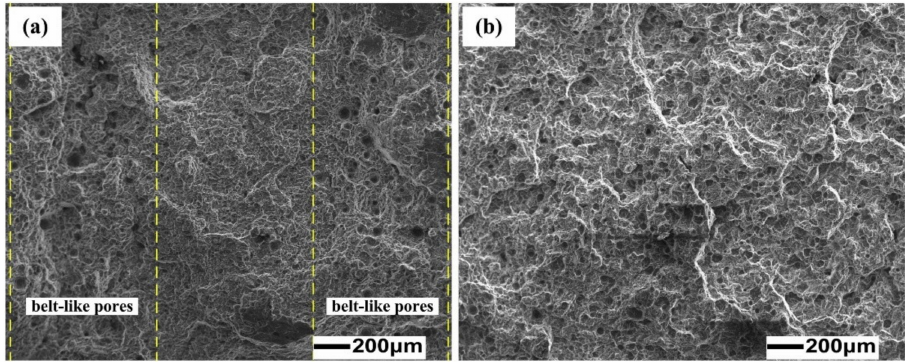
Figure 15. Fracture morphology for WAAM 2024 alloy in T4 condition: ( a ) horizontal direction; ( b ) vertical direction. Reprinted from Ref.